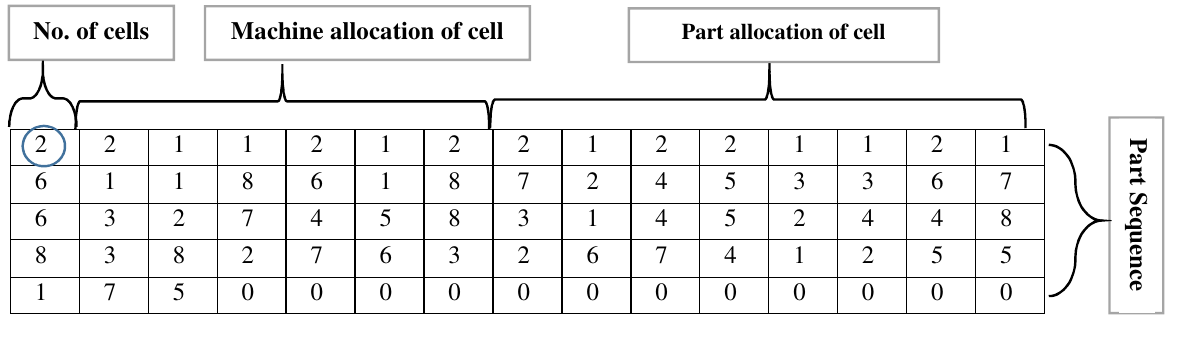
Table 1: 2D Chromosome of a 6 × 8